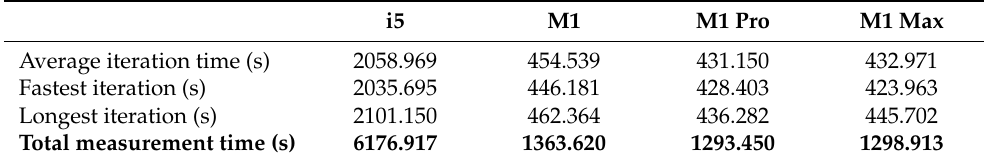
Table 11. Average iteration times of the ‘Benchmarker_Playground.playground’